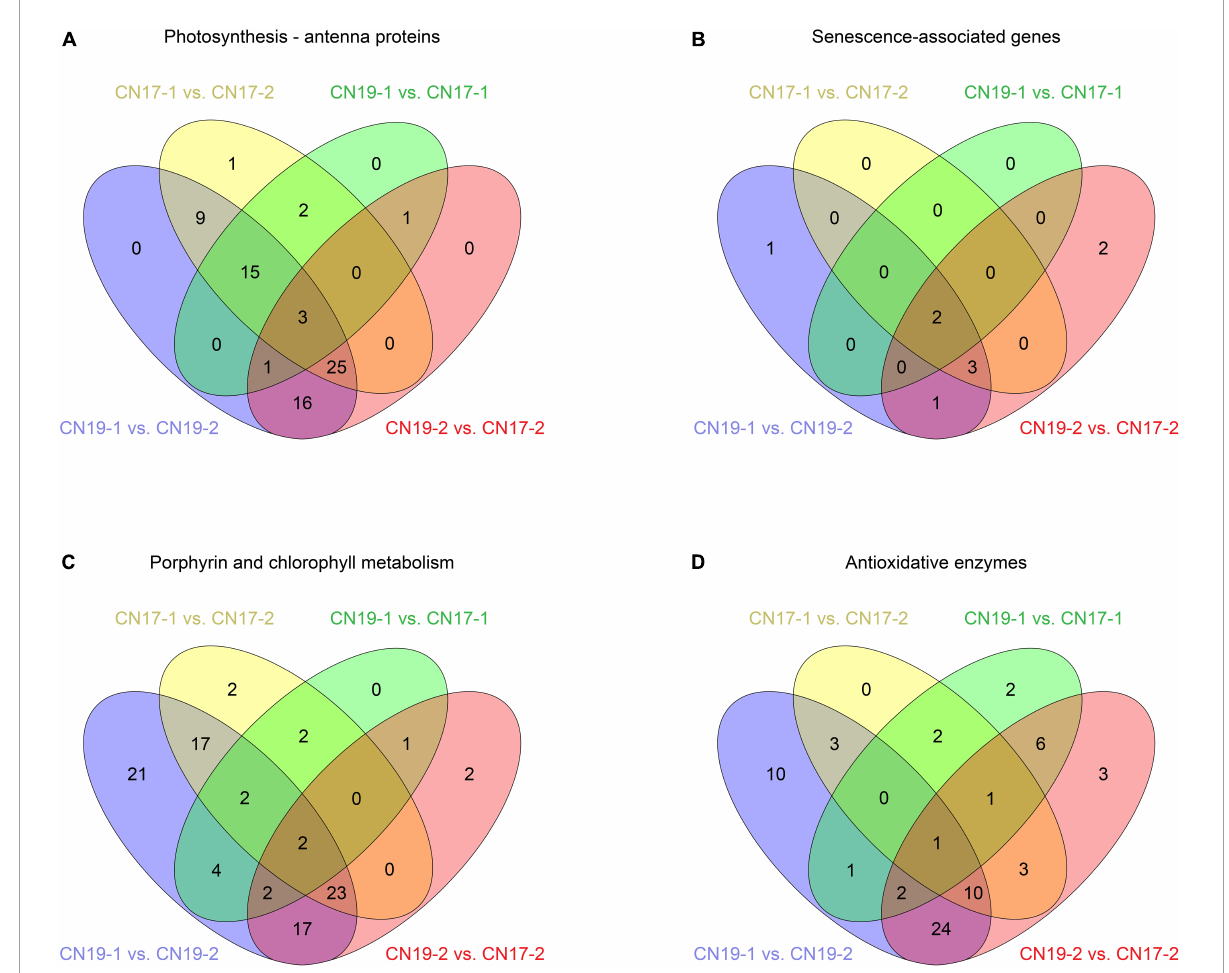
FIGURE5 Number of DEGs between different comparison groups. (A) Photosynthesis – antenna protein; (B) Senescence-associated genes; (C) Porphyrin and Chl metabolism; (D) Antioxidative enzymes. The number 1 and 2 behind the cultivar stand for 20 DAH and 40 DAH,